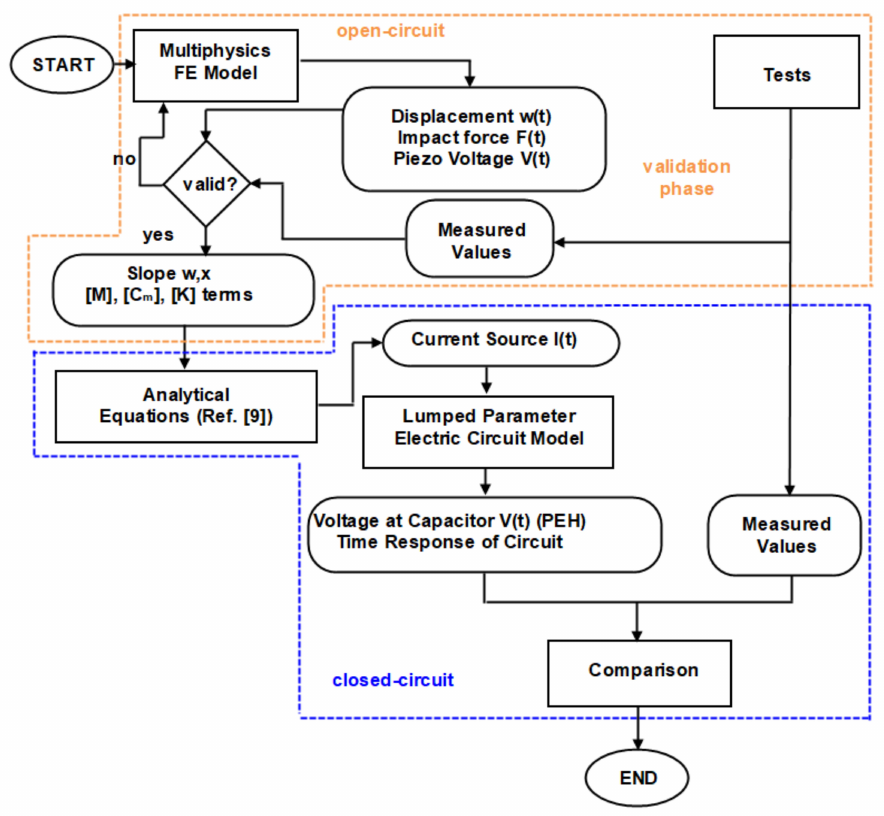
Figure 1. Flowchart of the experimental-numerical